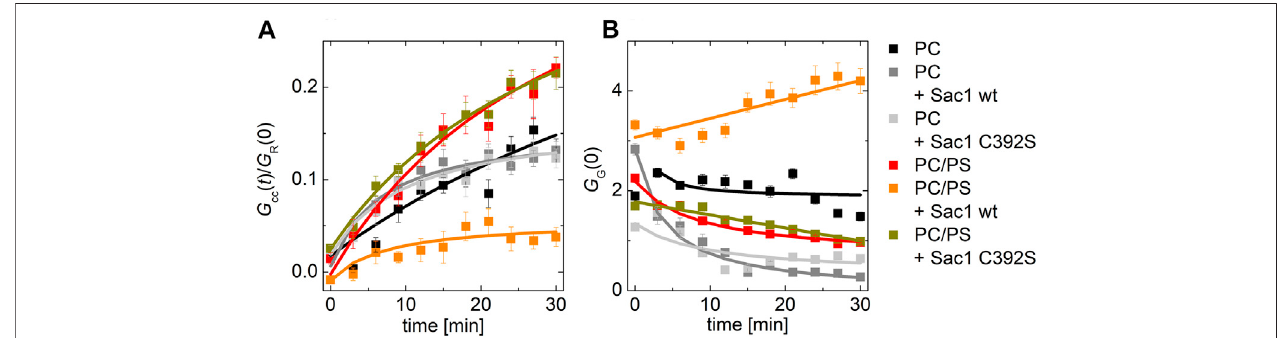
FIGURE 3 | PI4P transport followed by Sac1 dephosphorylation viewed by FCCS. (A) The temporal evolution of the transport-monitoring parameter G cc / G R and (B) the temporal evolution of the amplitude of the CFP autocorrelation function, and the parameter reporting on the biosensor binding G G . The PI4P-accepting membranewascomposed ofPOPCand thefollowing:i)notdecoratedbySac1(black squares),ii)decoratedbySac1 wt(darkgraysquares),andiii)decoratedbySac1 C392S(lightgraysquares).ThePI4P-acceptingmembranewascomposedofPOPC/PS(20 mol%ofPS)andthefollowing:i)notdecoratedbySac1(redsquares), ii) decorated by Sac1 wt (orange squares), and iii) decorated by Sac1 C392S (dark yellow squares). The error bars stand for the standard deviation. The presented data represent the trends that were observed in minimum three independent